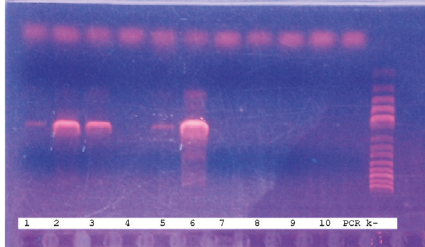
Figure3:Theresultsofamplificationofnucleicacidsextractedfrom the samples using universal primers specific for the 16S rRNA